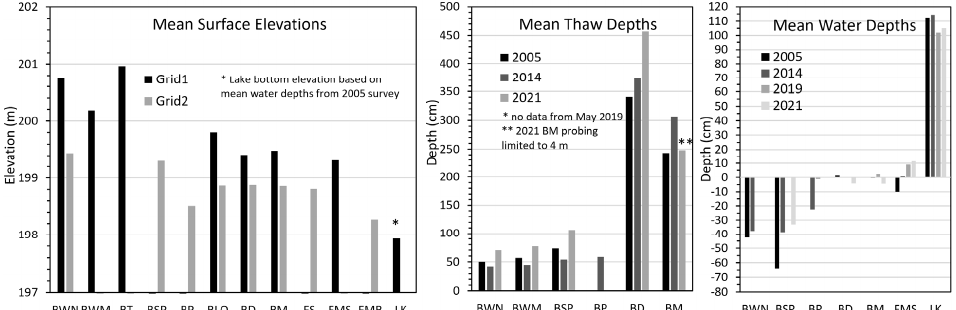
Figure 6. Mean surface elevations from 2019 DEMs ( left ), and mean thaw ( center ) and water depths ( right , negative when below ground) from transect surveys from 2005 to 2021 by ecotype. Surface elevations compare differences between Grid 1 (high plateau) and Grid 2 (low plateau). Ecotypes include black spruce bog (BWN), spruce–birch bog (BWM), tussock bog (BT), barren bog (BP and new permafrost), dwarf birch scrub bog (BLO, old), ericaceous scrub bog (BD, intermediate), meadow bog (BM, young), scrub fen (old), sedge meadow fen (FMS, shore), buckbean meadow fen (FMB, collapse scar), and lake